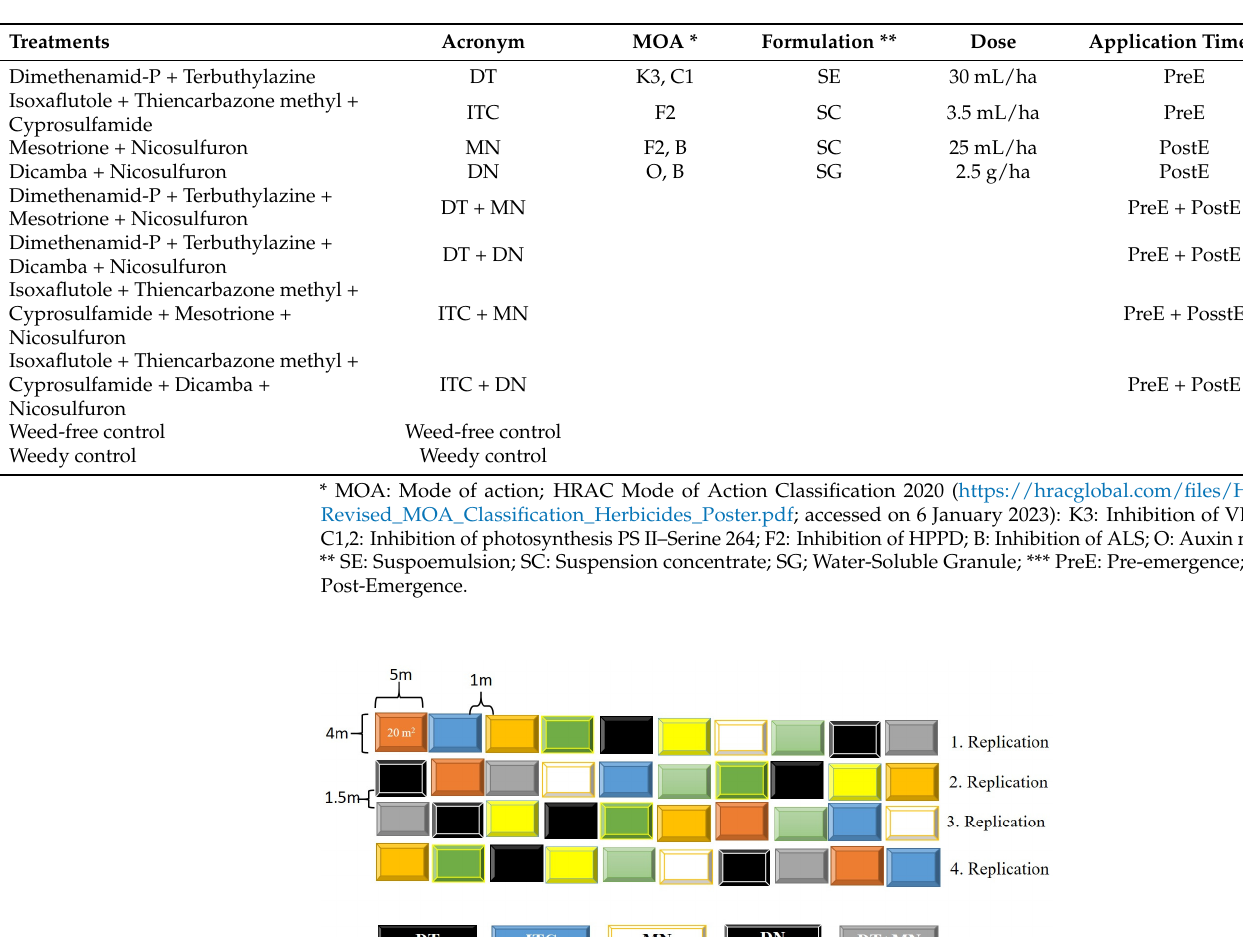
Table 2. Active ingredients, mode of action, formulations, dose, and applications times of herbicides.